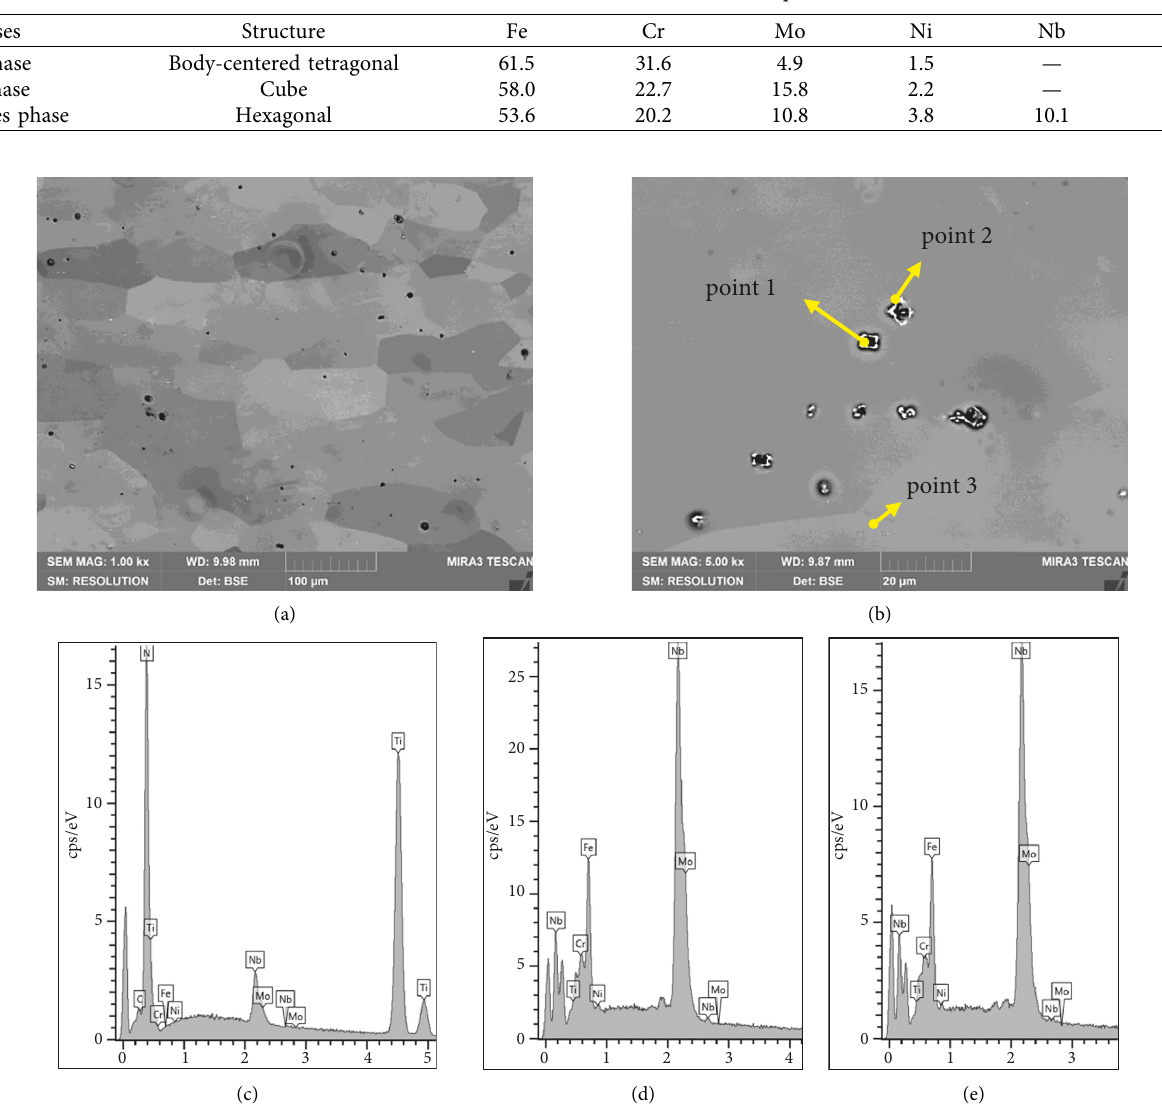
Figure 1: The microstructure and EDS results of the precipitated phase in the solution-treated samples before a fire treatment (a) 1000 × , (b) 5000 × , (c) EDS of TiN for point 1, (d) EDS of Nb (CN) for point 2, (e) EDS of Nb (CN) for point